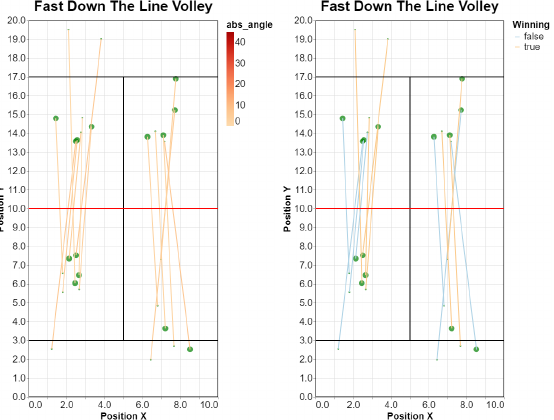
Figure 12. Direction of fast, down-the-line volleys for the test match, with shots colored by angle ( left ) or depending on whether the player won the point, after this shot or later on ( right